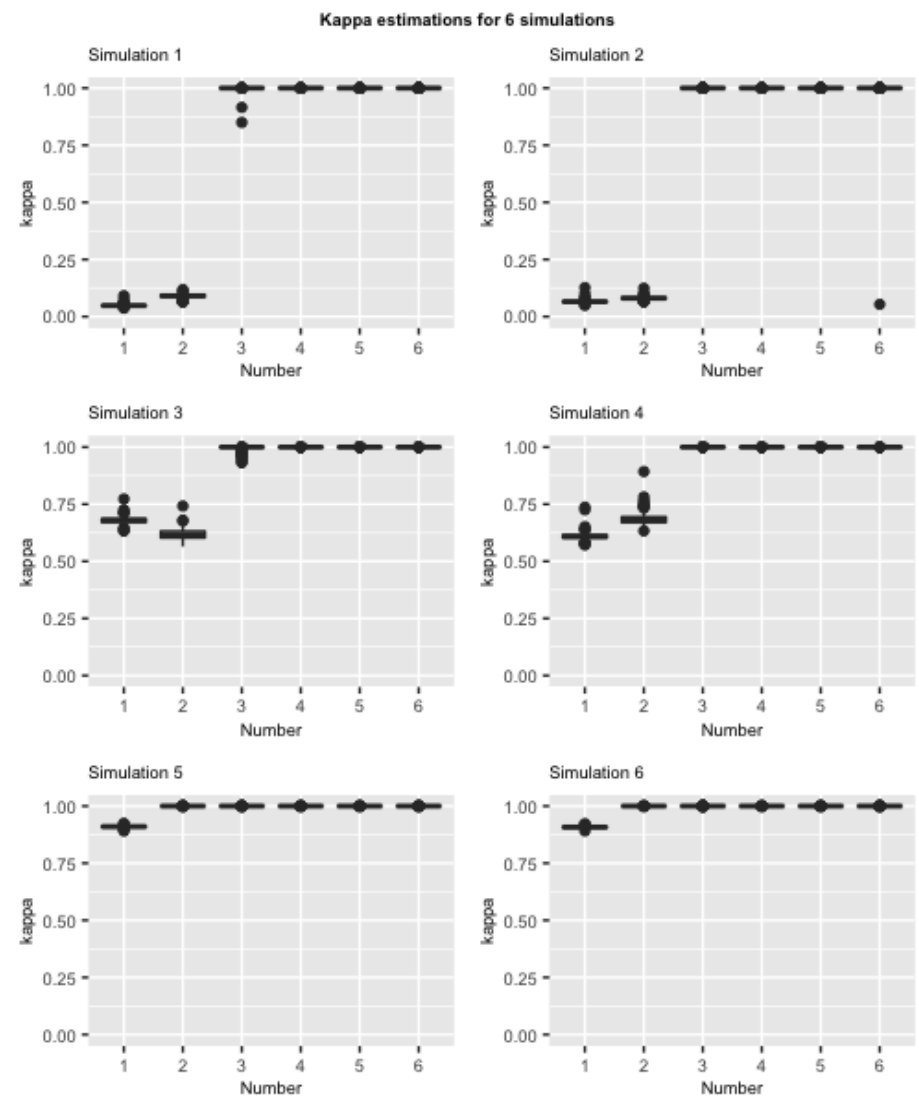
Figure 3. Box-plots of shrinkage profile estimations ˆ κ j for j = 1, . . . , R from 180 nowcast estimates. Here, R = 6. Each subplot represents the result for each